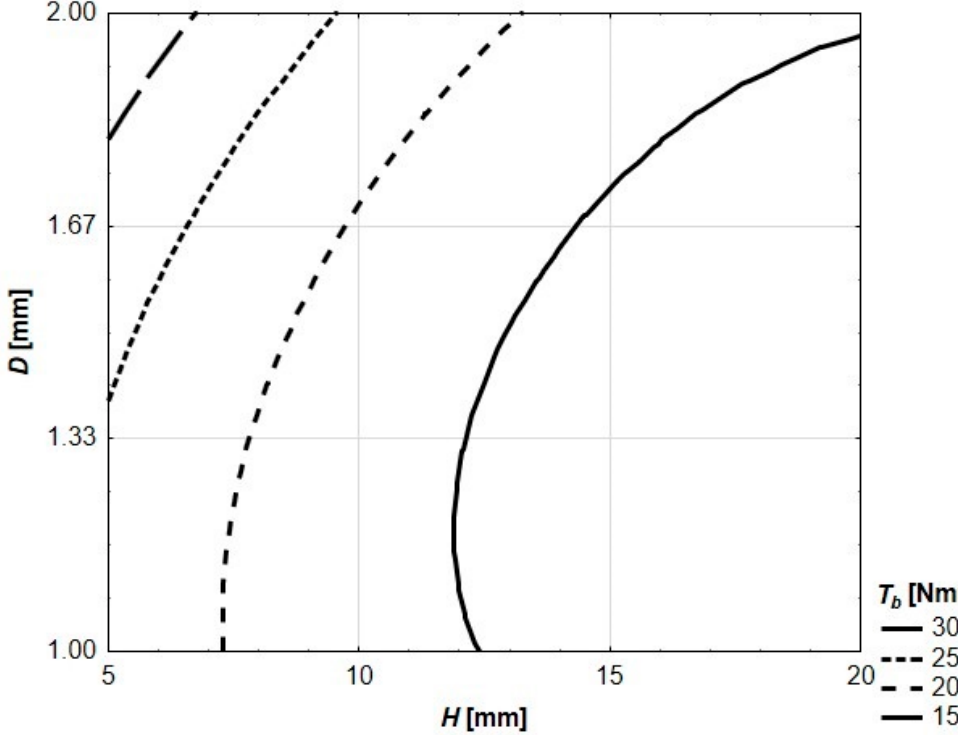
Materials 2020 , 13 , x FOR PEER REVIEW Figure 7. Flexural toughness of tested prism specimens for the first peak of loading force.